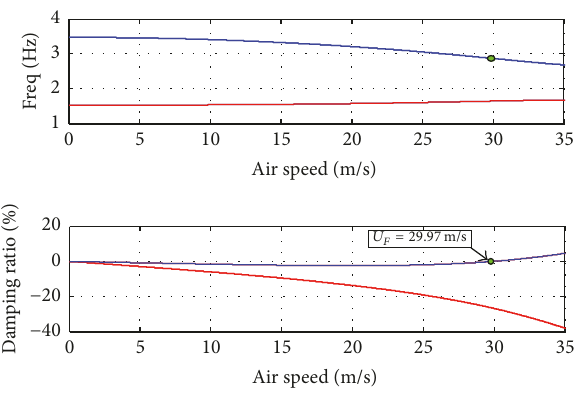
Figure 8: Variations in two damping coefficients and pitch and plunge frequencies versus speed derived from quasi-steady aerody- namic equations. Flutter speed is about 𝑈 𝐹 = 29.97 m/s.